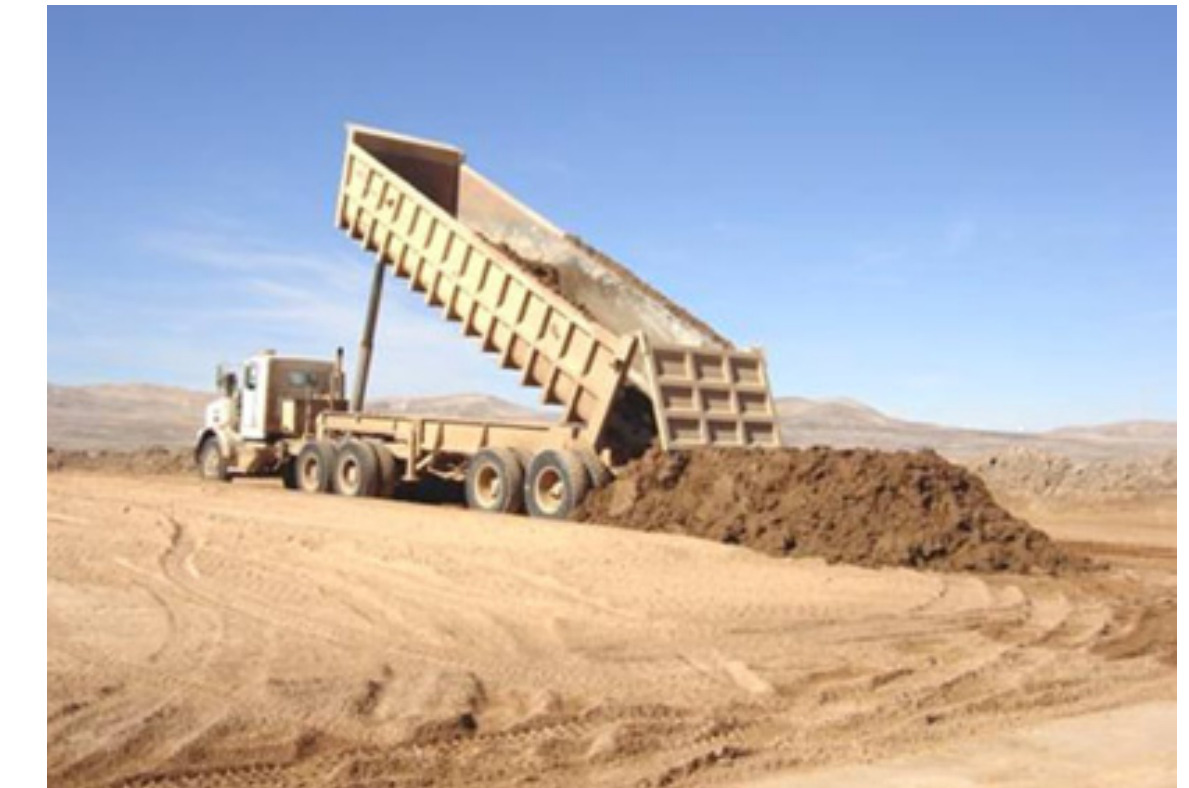
Figure 32. El Peñon Filtered Tailings Storage Facility—Haul Truck with Tails Disposal [62,63].